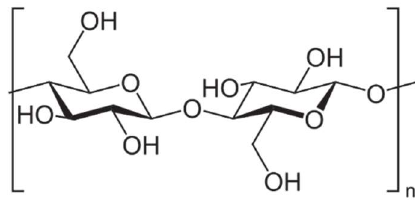
Figure 4. Structure of cellulose.